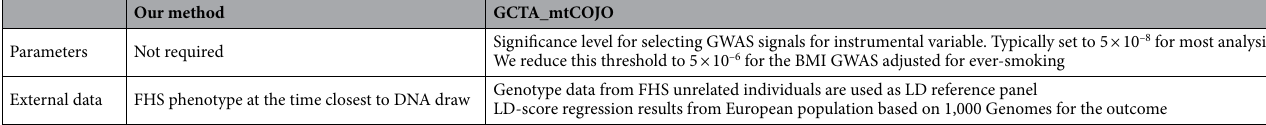
Table 2. Details of the estimation of the trait relationship using our method and